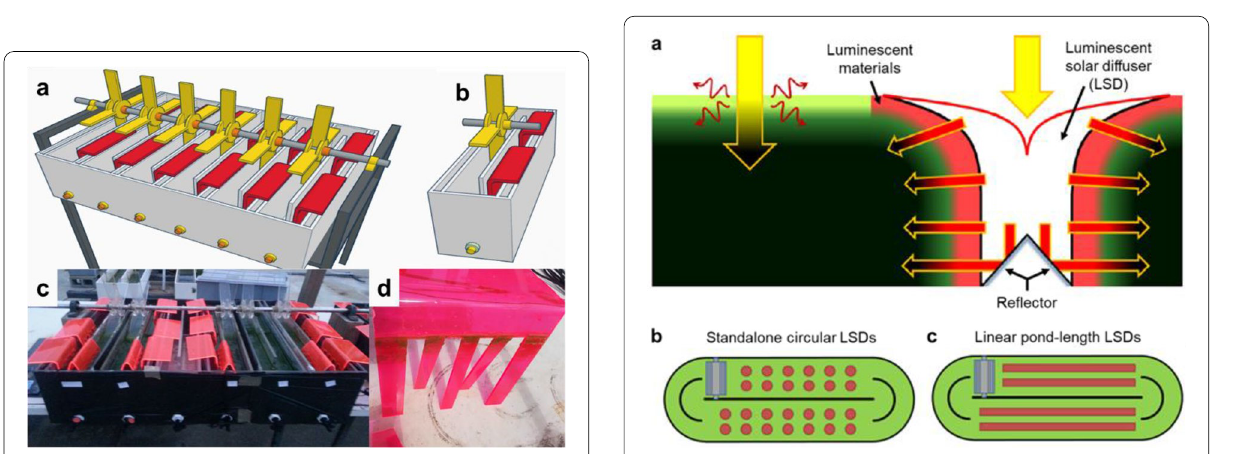
Fig. 10 a Schematic, b singular, and c structure view of raceway ponds equipped with red spectral conversion panels with a culture volume of 21.5 L for each pond. d Scenedesmus sp. biofouling on a panel during 15 days of the cultivation period. Reproduced with permission from [137].